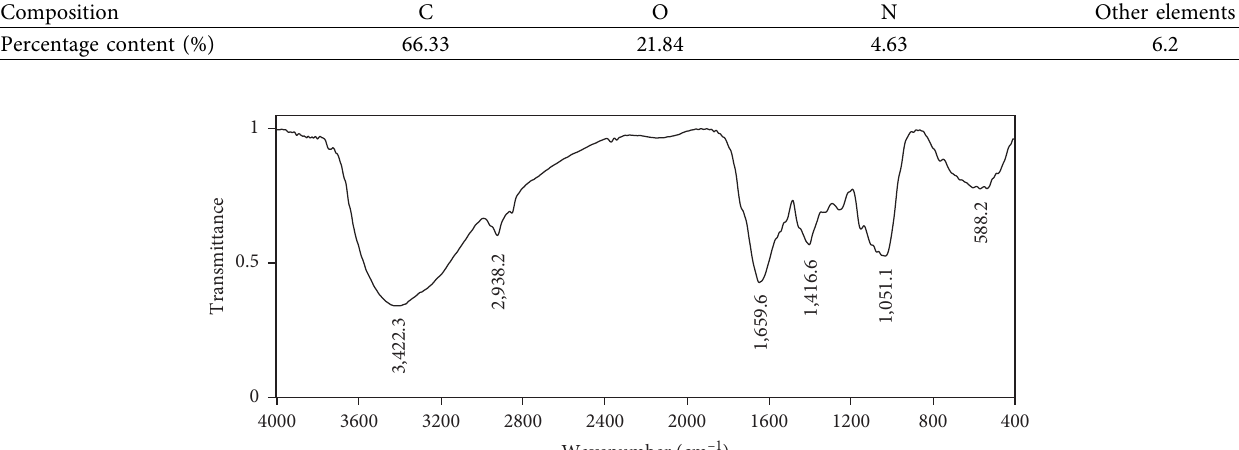
Figure 2: SEM images of the WM adsorbent: (a) 50 μ m; (b) 10 μ m. Table 1: Percent for major atomic composition determined by EDX.